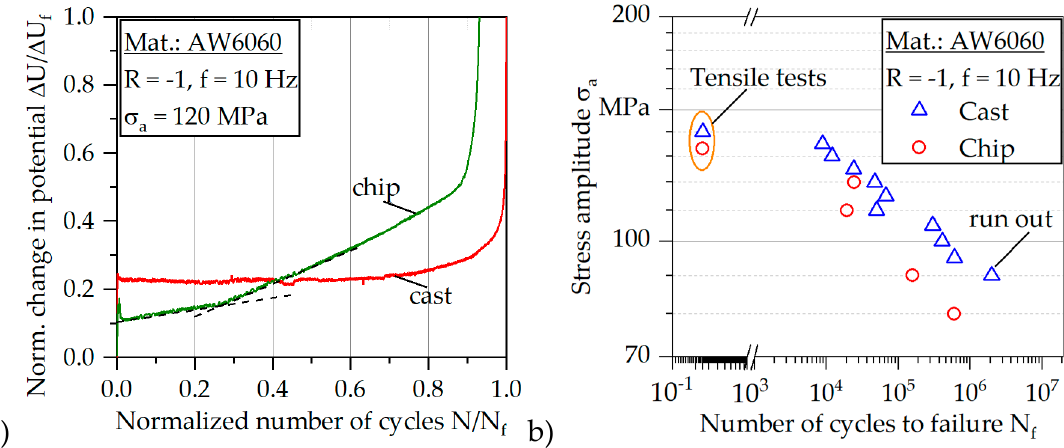
Figure 10. Change in potential for cast-based and chip-based specimens ( a ), S-N curve for cast-based and chip-based specimens ( b ).